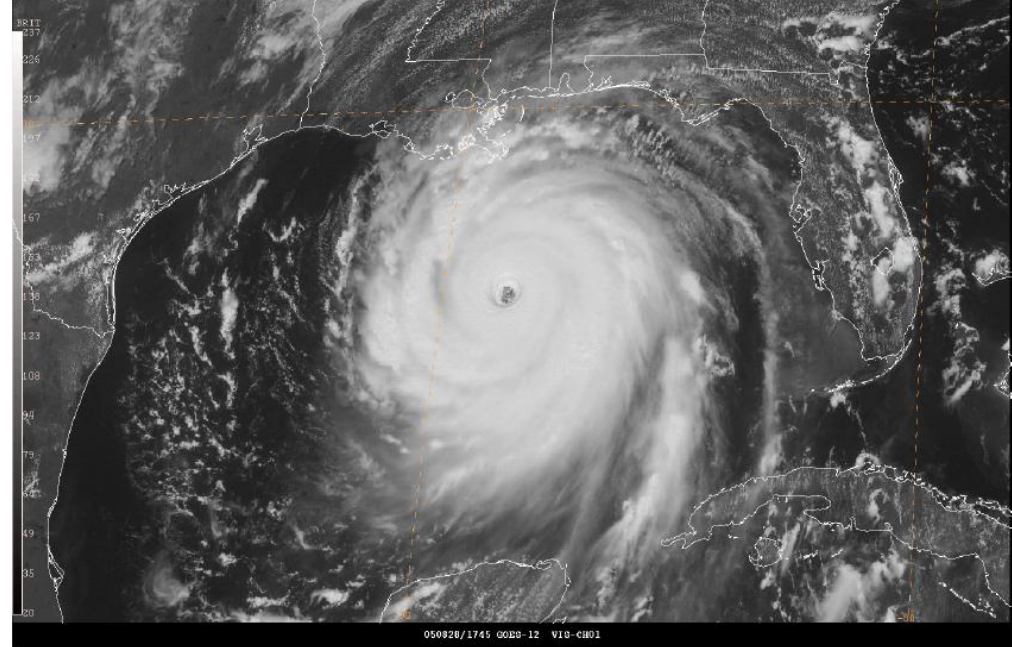
Figure 6. GOES-12 visible image by NHC [9,10] of Hurricane Katrina, over the central Gulf of Mexico at 1745 UTC 28 August 2005, as a category 5 near the time of its peak intensity of 150 kt.